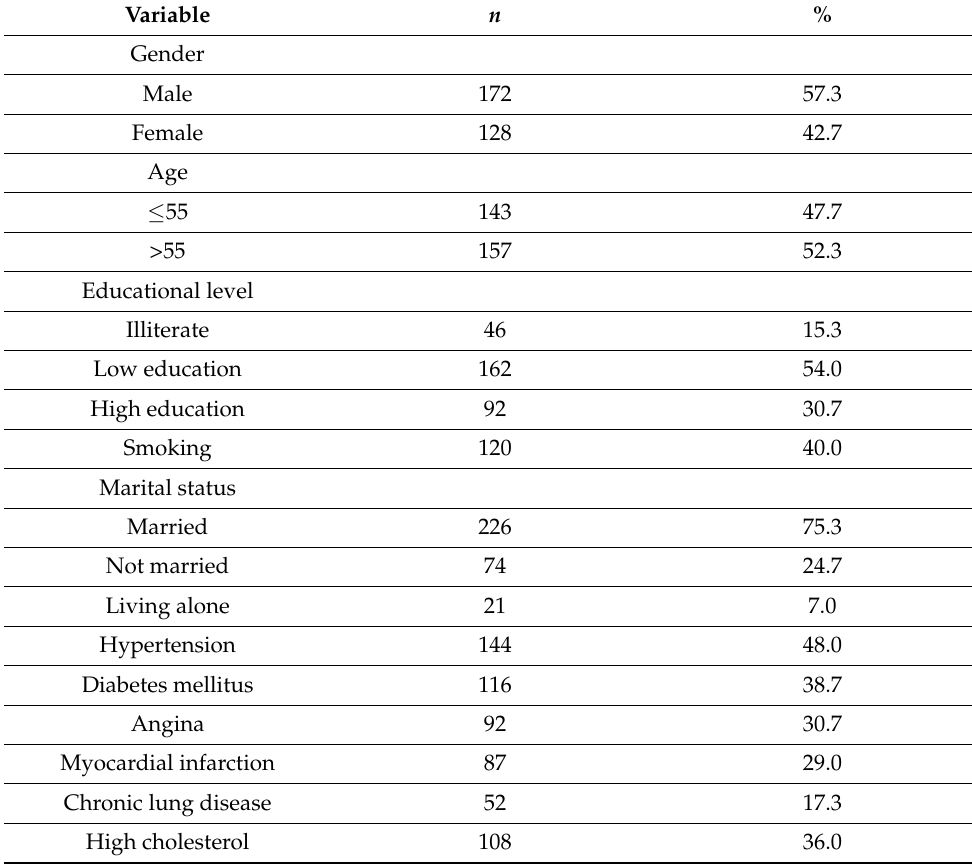
Table 1. The socio-demographic and clinical characteristics of patients with chronic heart failure ( n = 300).